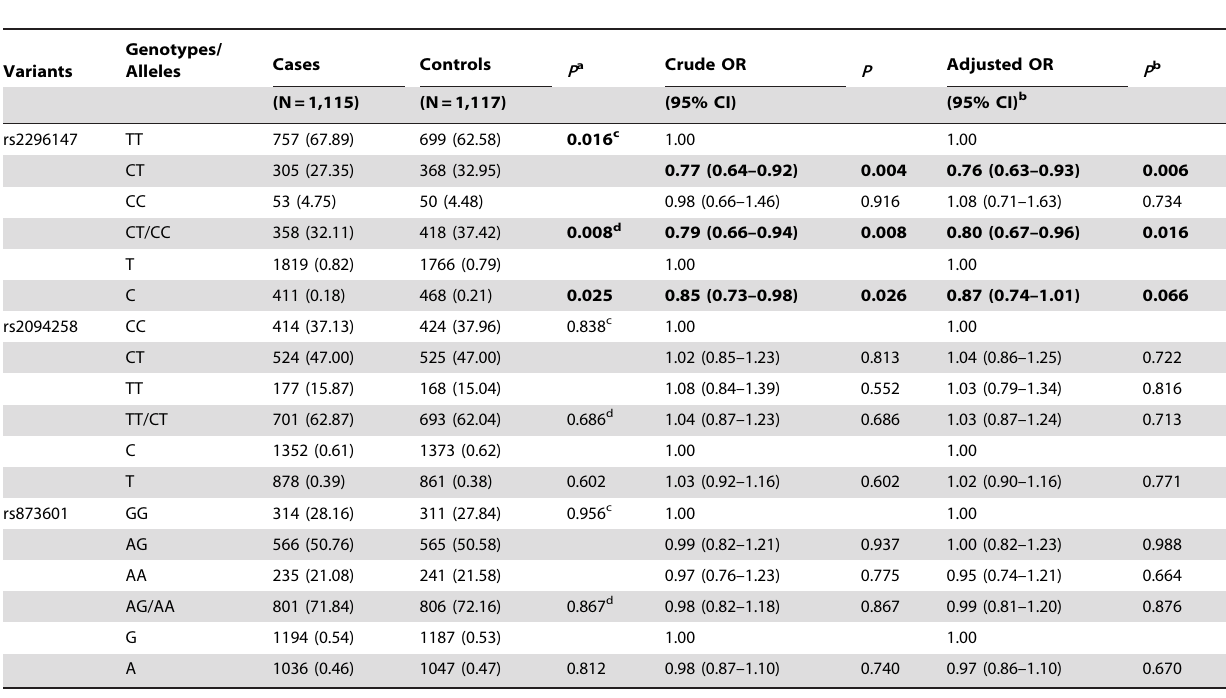
a Chi-square test for genotype distributions between cases and controls. b Adjusted for age, sex, body mass index (BMI), smoking status, and drinking status in logistic regress models. c for additive genetic models. d for dominant genetic